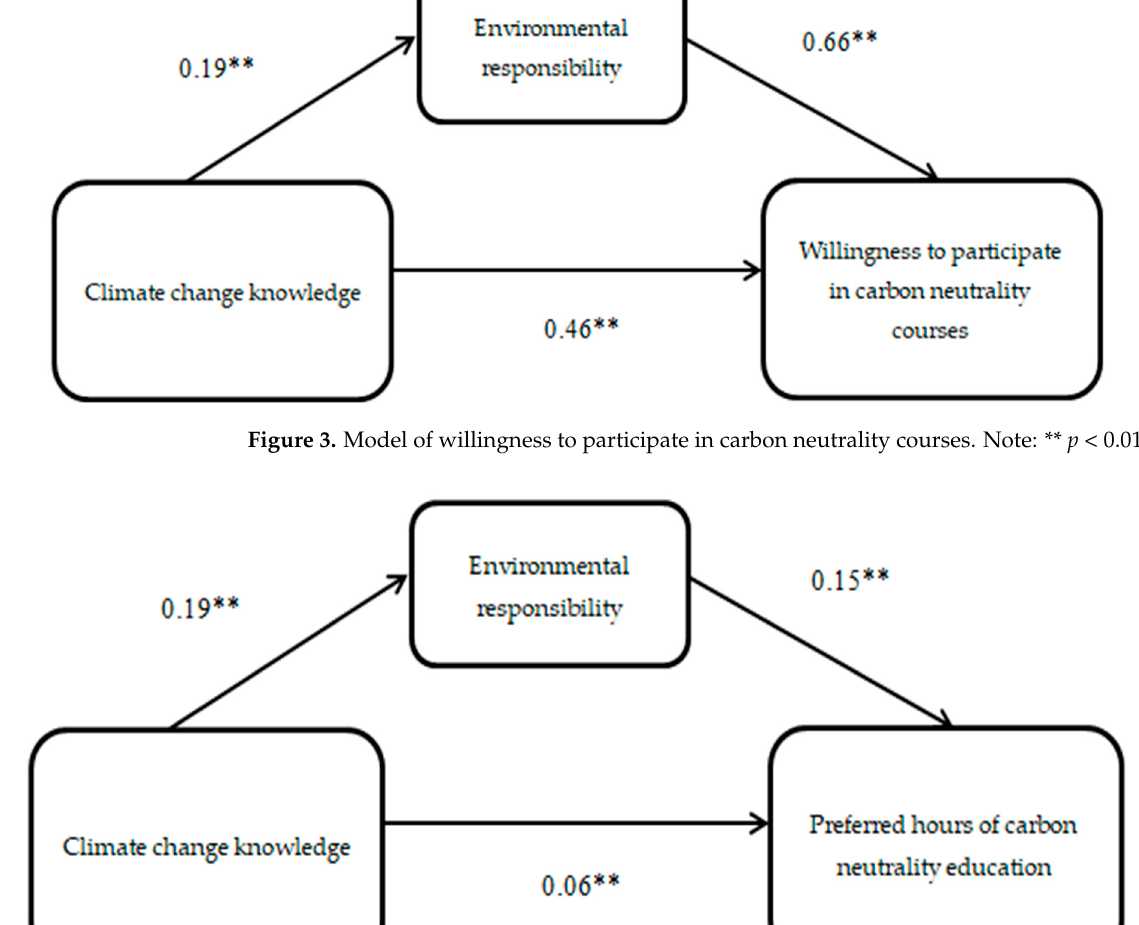
Figure 2. Model of supportive attitudes toward carbon neutrality education. Note: ** p < 0.01.